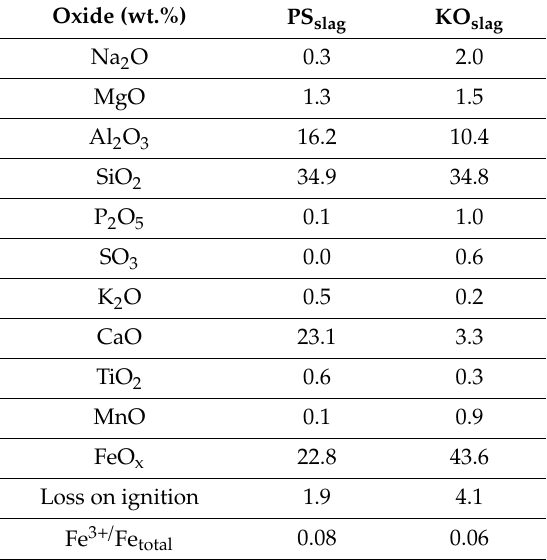
Table 3. Representative oxide composition of the precursors used.